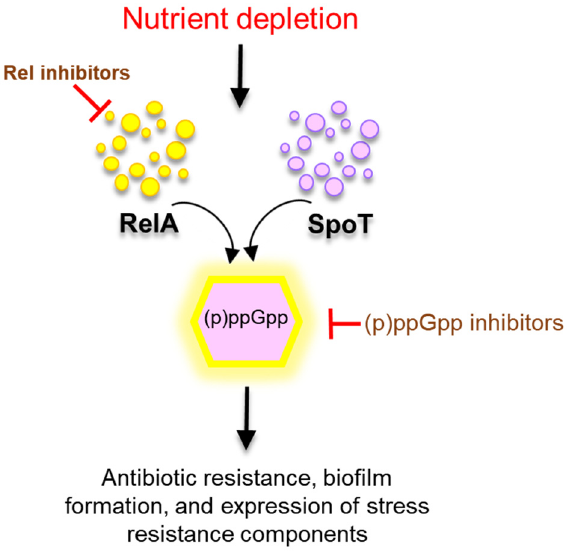
Figure 7. Bacterial nutritional stress response by the (p)ppGpp system.